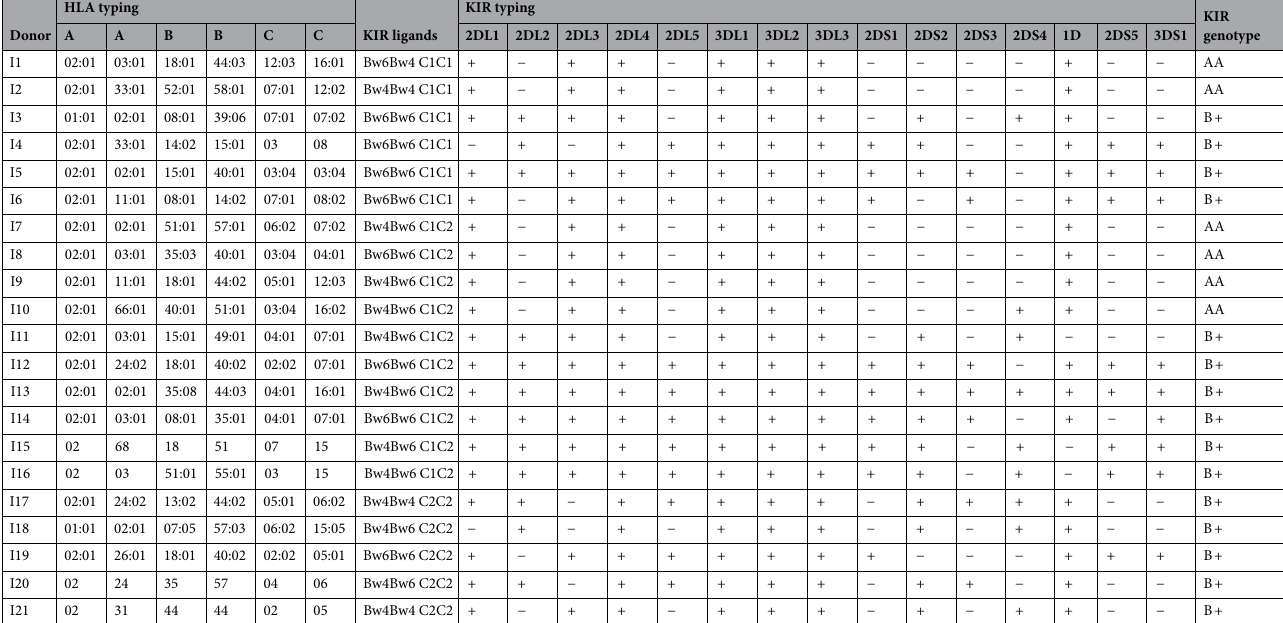
Table 1. HLA and KIR genotypes of studied CMV + volunteer blood